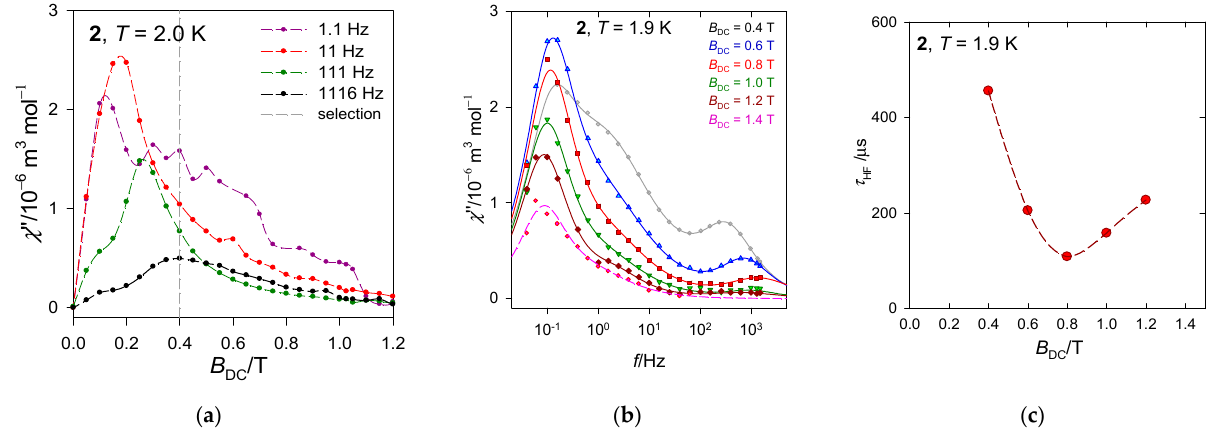
Figure 9. AC susceptibility and relaxation time for 2 . Solid lines—fitted. ( a )–field dependence, ( b ) frequency depenence, ( c )–relaxation time vs field.